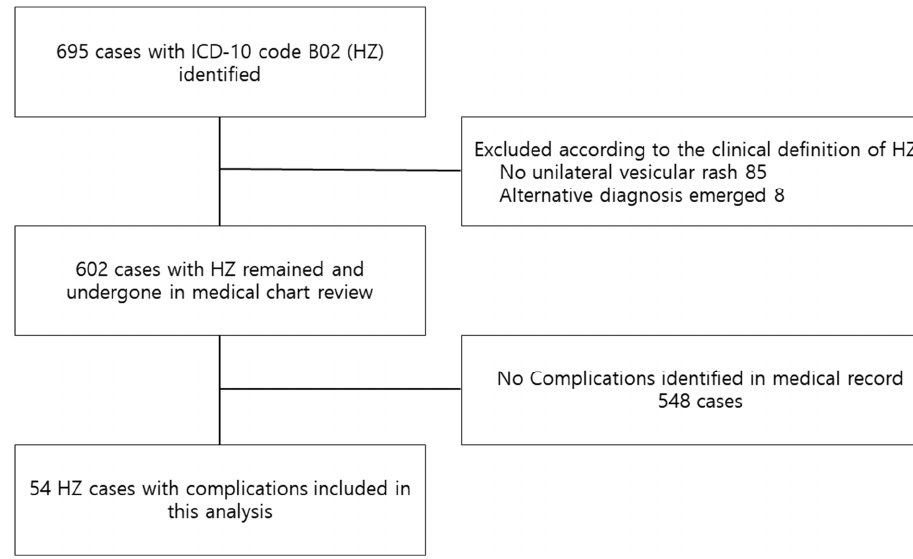
Figure 1. Flow chart of the patient-selection process. HZ, Herpes zoster.